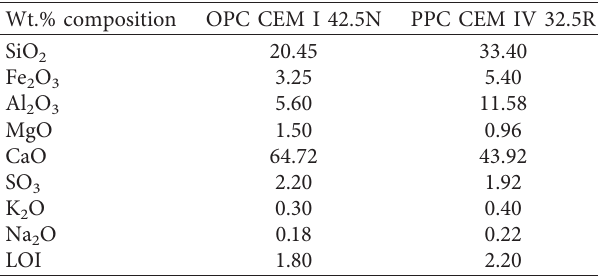
Table 1: Chemical properties of test cements.